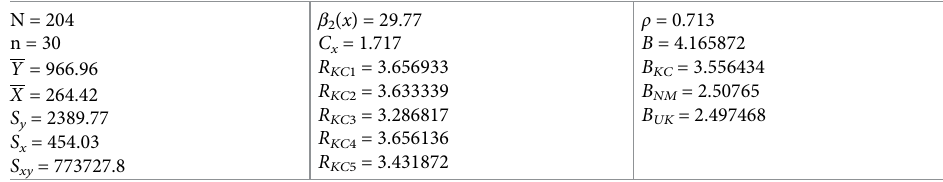
Table 1. Parameters of apple production